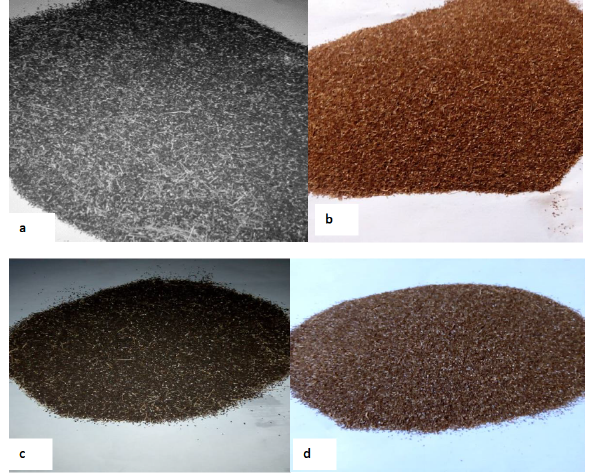
Figure 2: (a) 250 µ m PKS sample, (b) 250 µ m CNS sample, (c) 420 µ m PKS sample, (d) 420 µ m CNS sample